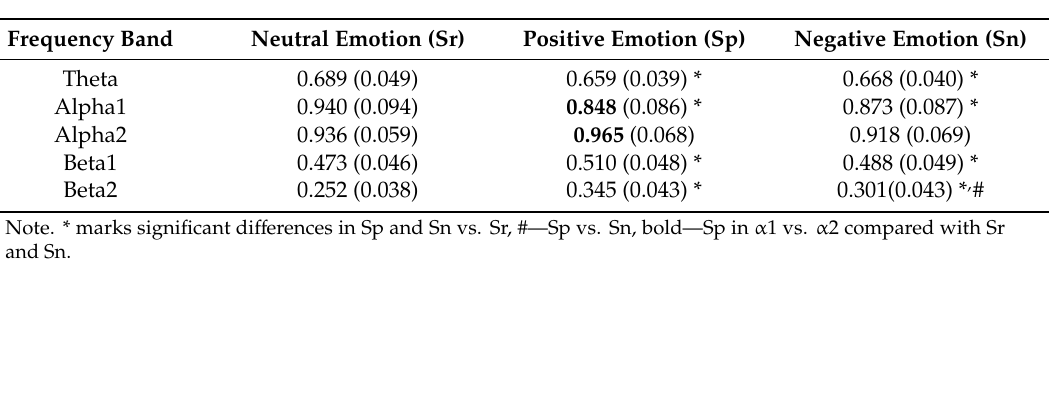
Table 1. Significant di ff erences between emotional state-induced EEG